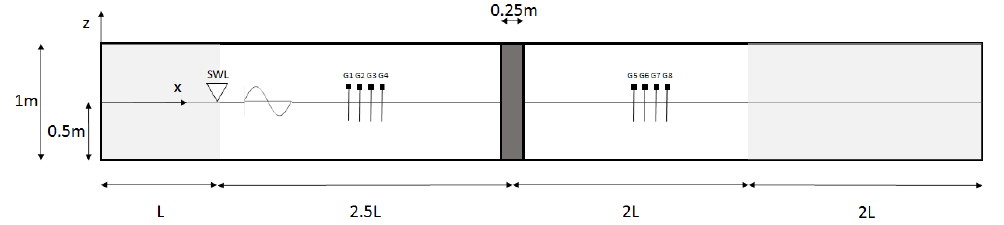
Figure 7. NWT used for simulations with a vertical